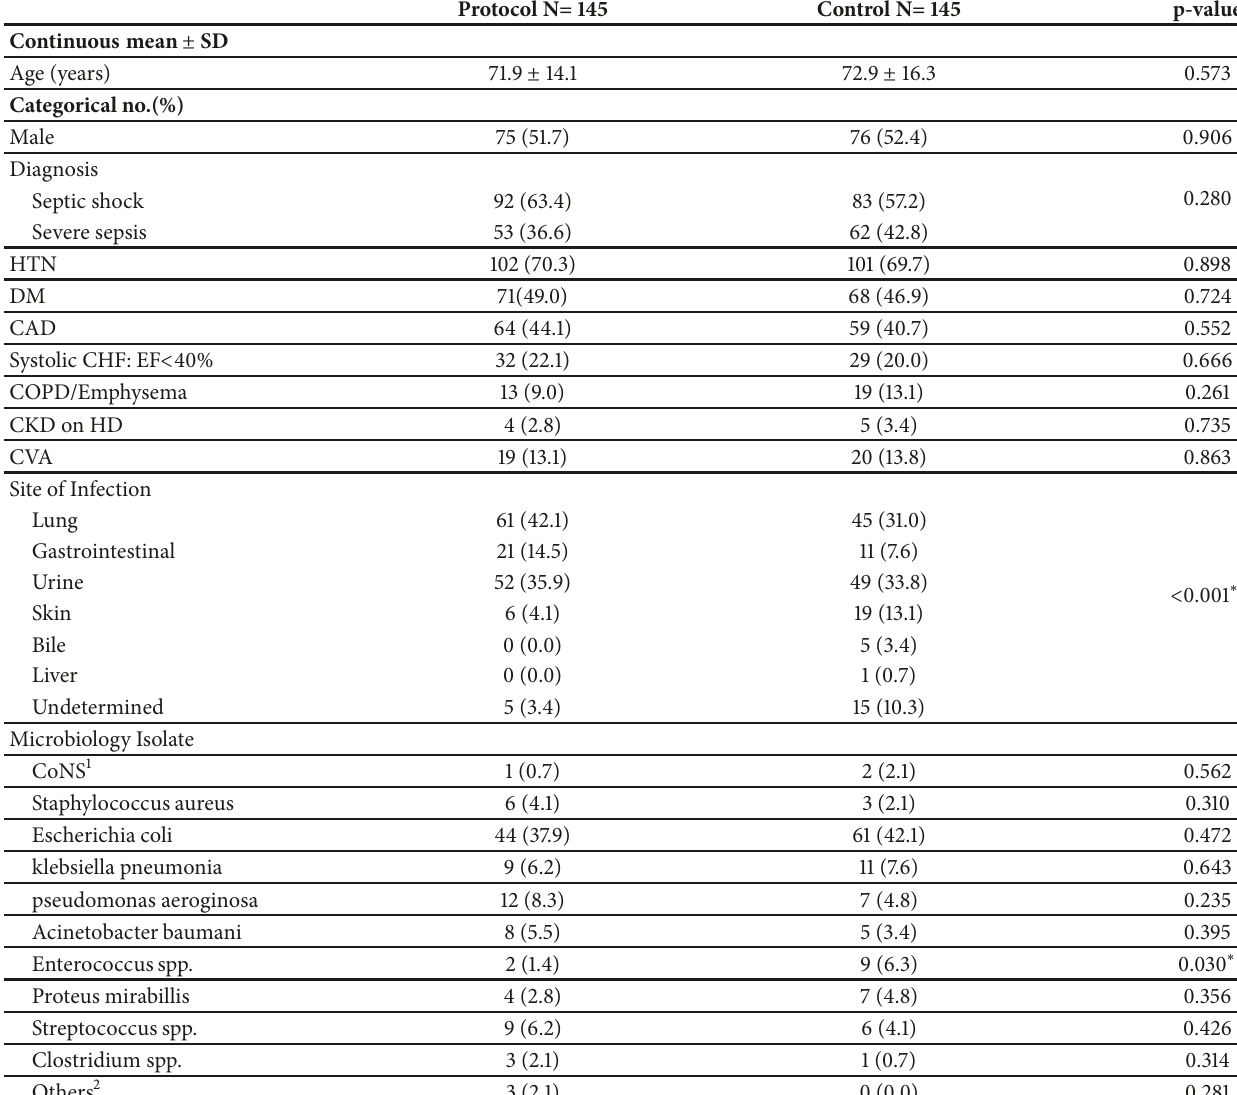
Table 1: Patient